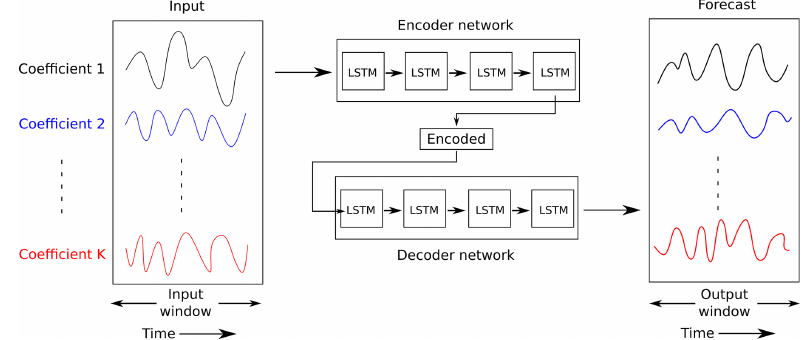
Figure 1. A schematic for forecasting POD coefficients using an encoder–decoder LSTM neural network. The various POD coefficients of an input window are encoded to a latent state on which the forecast window is